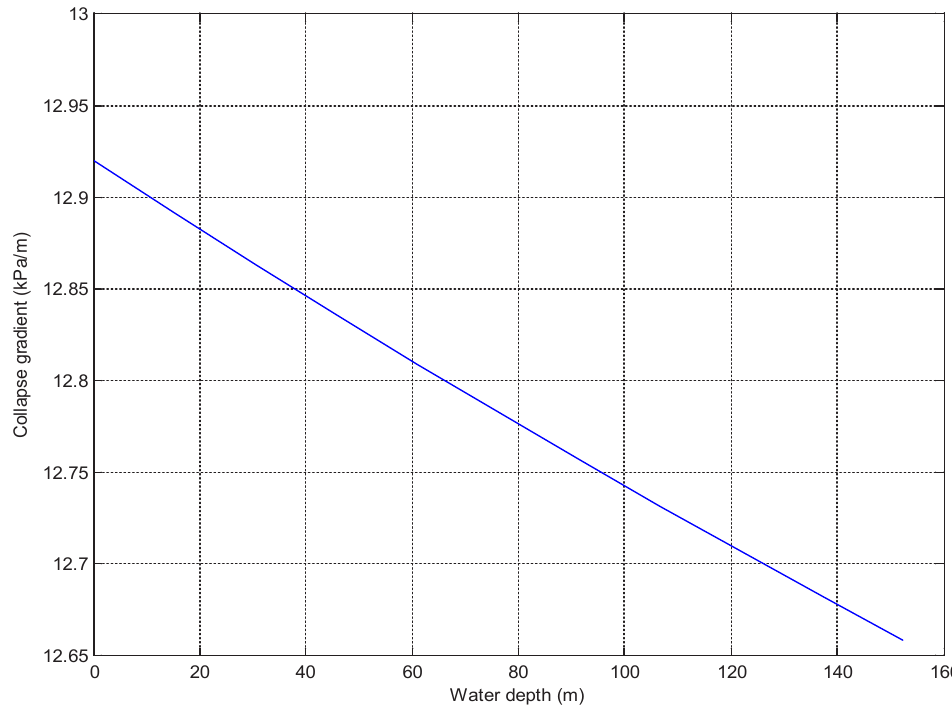
Figure 1 - Effect of water depth on the critical mud weight